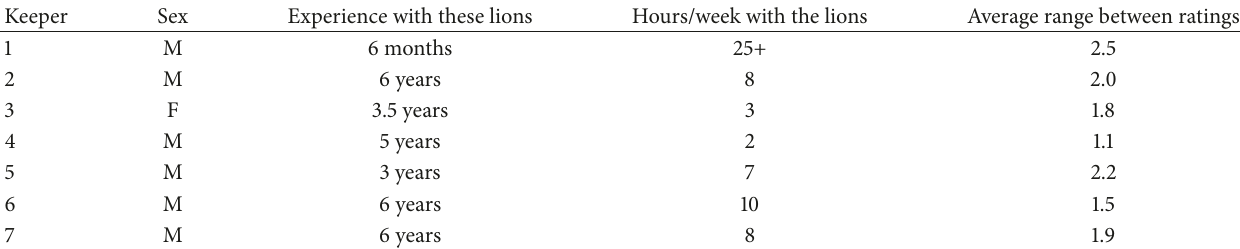
Table 9: Summary of keepers who completed lion personality questionnaires in